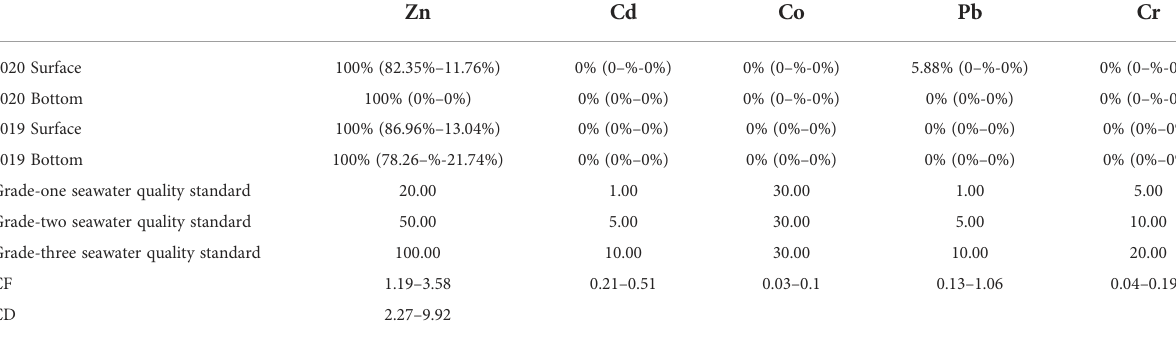
TABLE 2 Rates of dissolved trace metal concentrations at sampling locations exceeding the Chinese